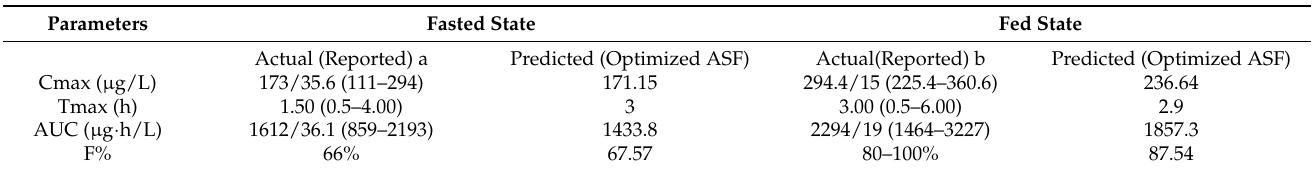
Table 7. Key pharmacokinetic parameters predicted from the simulation of Xarelto (20 mg) IR tablet in the fasted and fed states.